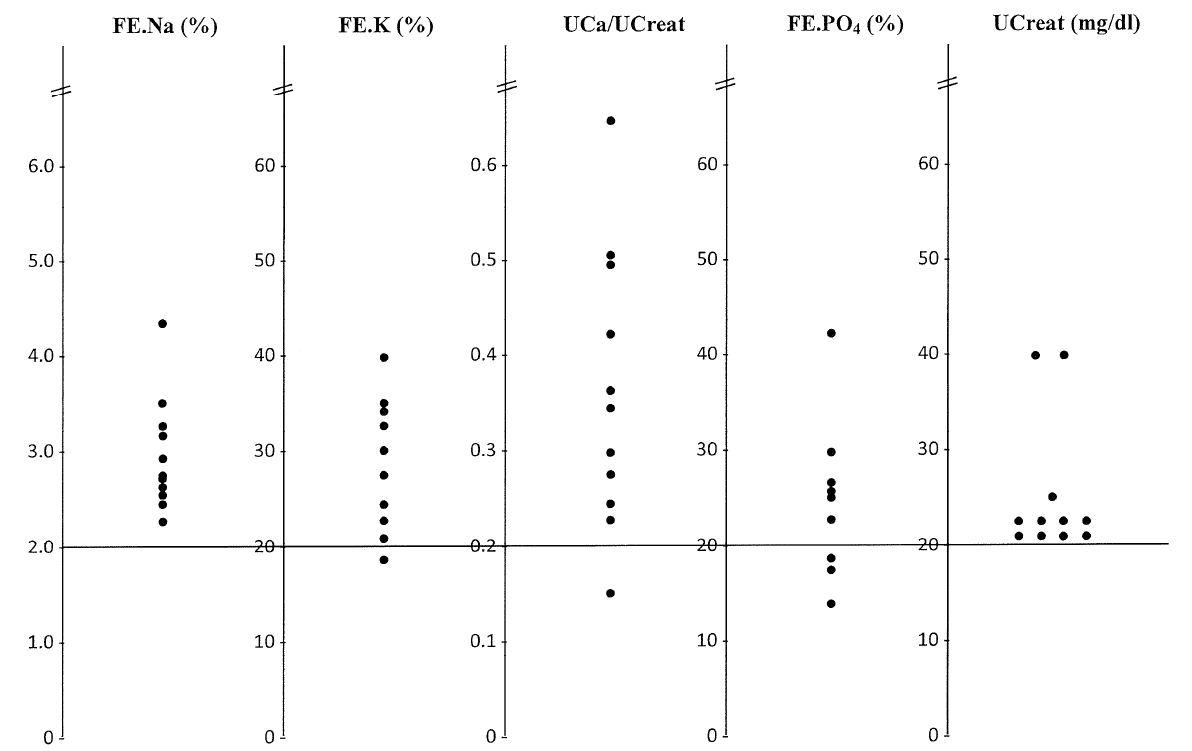
Figure 1. Patients with TRSL (transient renal sodium loss); UCa/UCreat represent the calciuria expressed per mg of creatinine, and diuresis is expressed by the urine creatinine concentration.